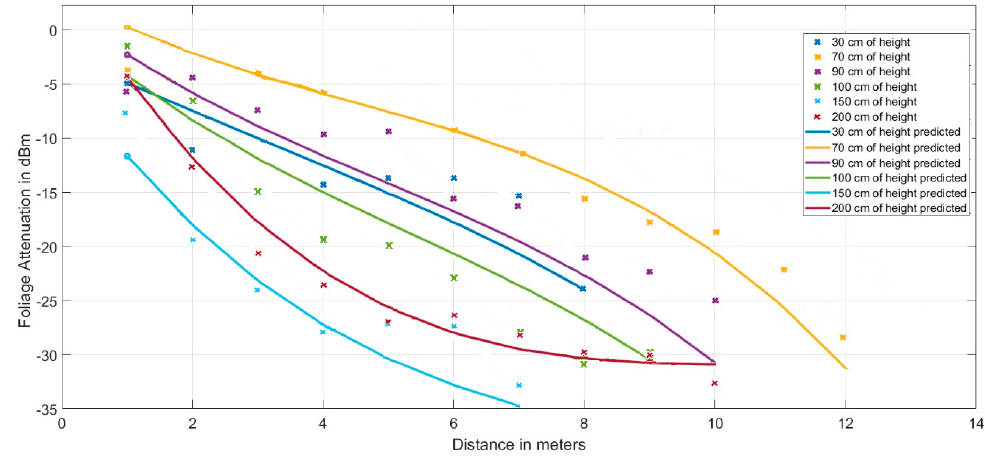
Figure 12. Curves of the proposed model vs. values taken in field tests in the year 2018.